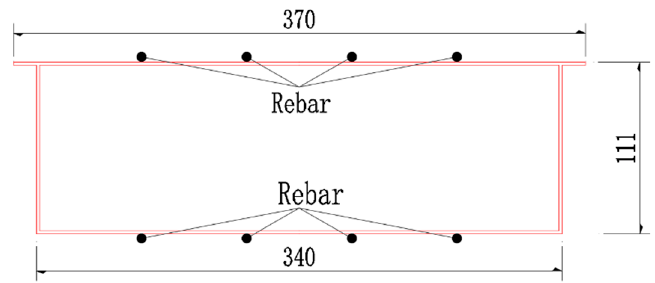
Figure 3. The standard section diagram of a girder model (unit: Mm).